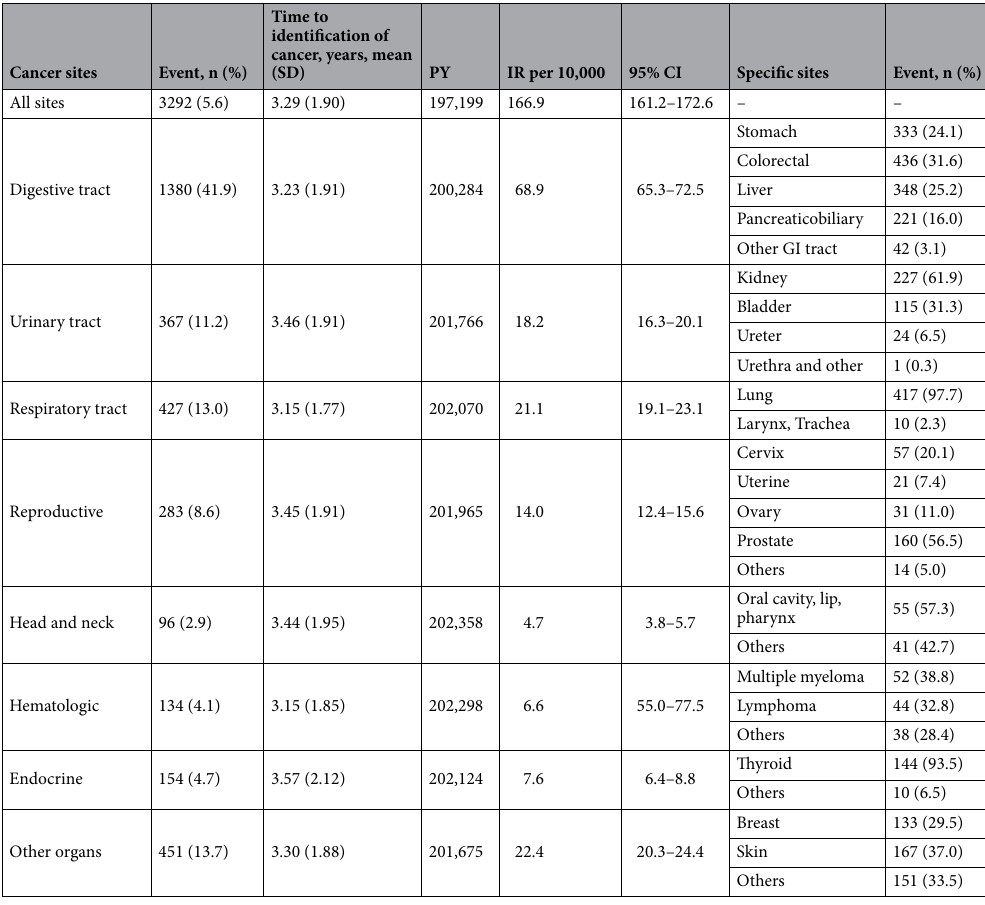
Table 2. Mean time to cancer identification and primary site of malignancy among ESKD patients. ESKD, end-stage kidney disease; SD, standard deviation; PY, person-years; IR, incidence rate; CI, confidence interval; GI,